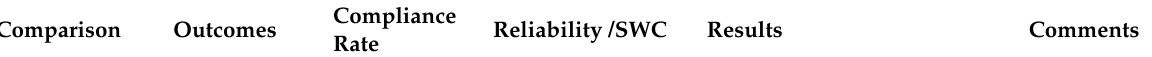
Table 3. Characteristics of the non-randomised studies included in the systematic